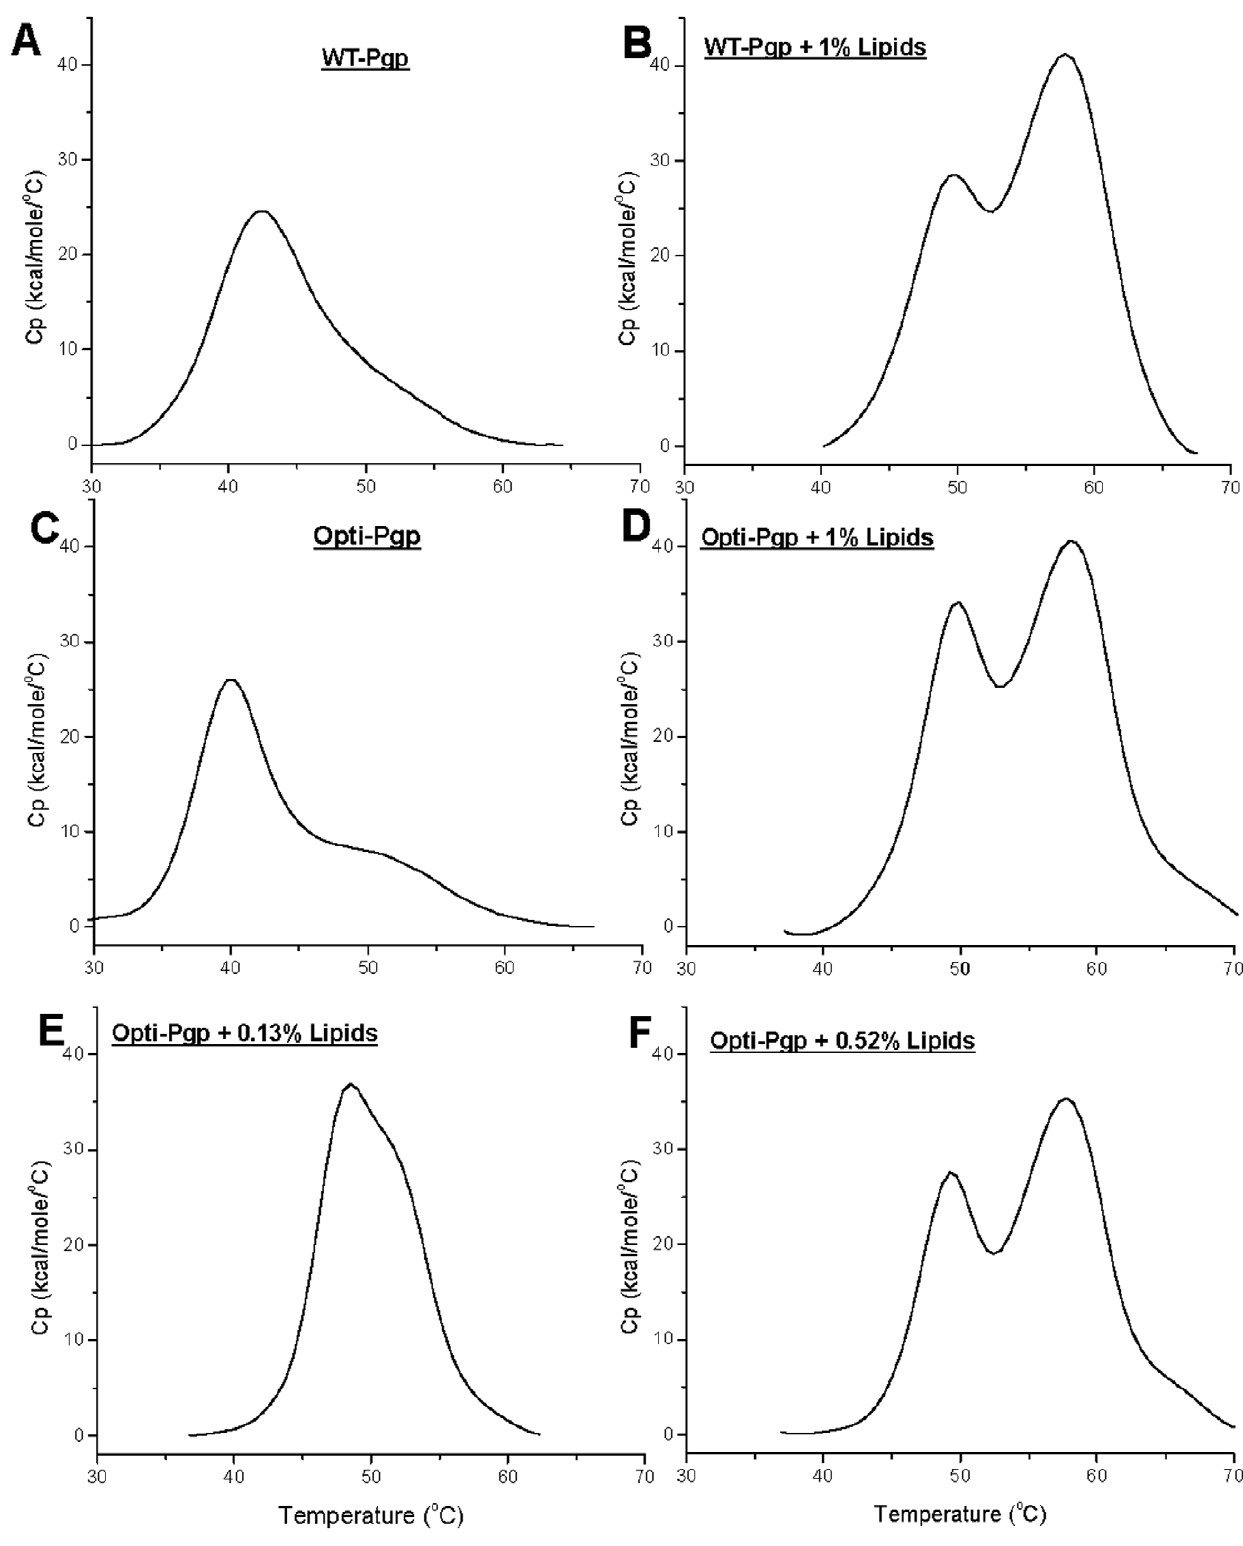
Figure 6. Differential Scanning Calorimetry of WT- and Opti-Pgp. Purified proteins were exchanged into buffer containing a defined DDM concentration (as in Fig. 3B), and the temperature dependence of the molar heat capacity recorded; protein concentrations ranged between 0.45– 0.78 mg/ml for WT-Pgp and 0.58–0.78 mg/ml for Opti-Pgp, respectively. Panels A and C: no lipid added. Panels B and D: Proteins were preincubated with 1% (w/w) E. coli lipid (lipid to protein ratio of 16:1, w/w) for 15 min at RT followed by 30 s bath sonication as described [13]. Panels E and F: Opti- Pgp was preincubated with 0.13% or 0.52% (w/w) E. coli lipid (lipid to protein ratios of 2.2:1 and 8.4:1, w/w)). Control samples containing the same amount of lipid had no detectable transition in the temperature range of protein unfolding.